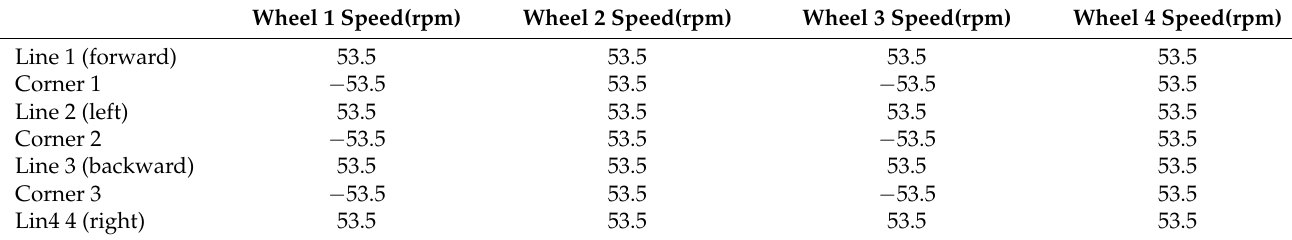
Table 10. Inputs for the differential drive no-loop kinematic solution—values.